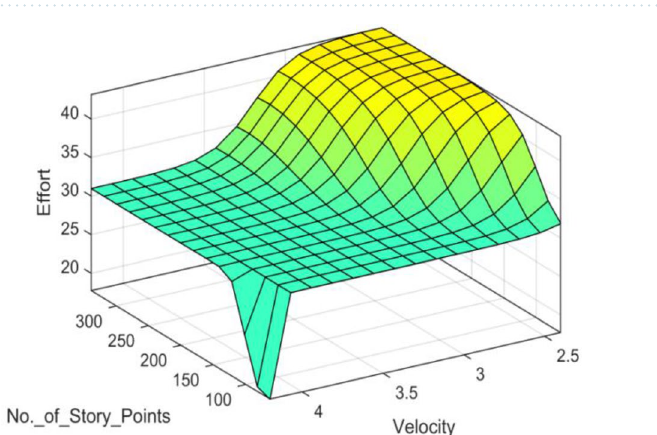
Figure 6. ANFIS-EEBAT surface plot.